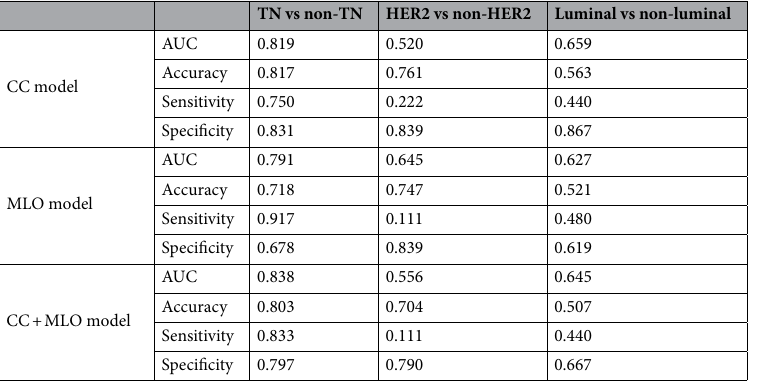
Table 2. Classification performance of the radiomics models in the validation cohort. TN triple-negative, AUC area under the receiver operating characteristic curve.